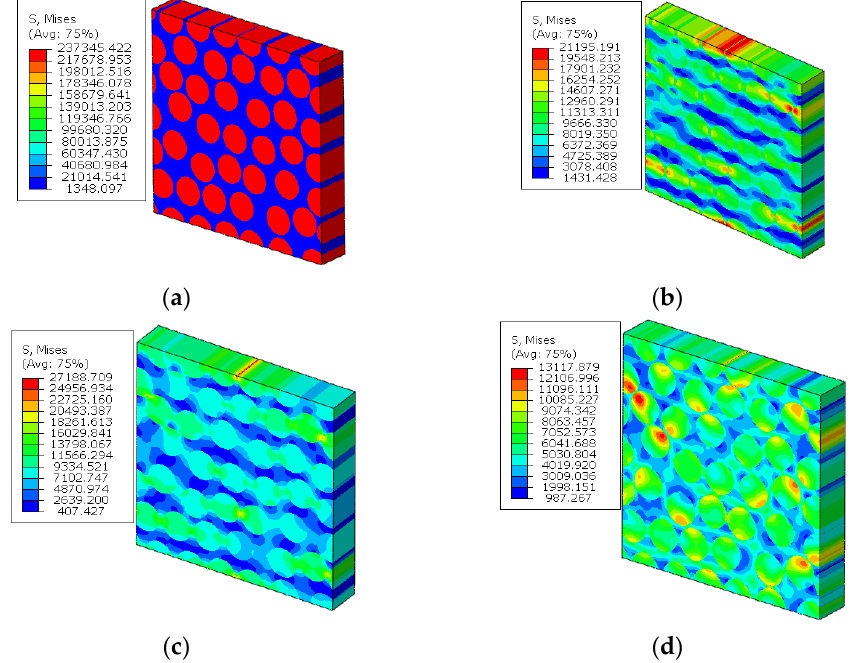
Figure 14. Stress distribution patterns for the fiber random distribution model. ( a ) longitudinal tensile loading; ( b ) transverse tensile loading; ( c ) longitudinal shear loading; ( d ) transverse shear loading.